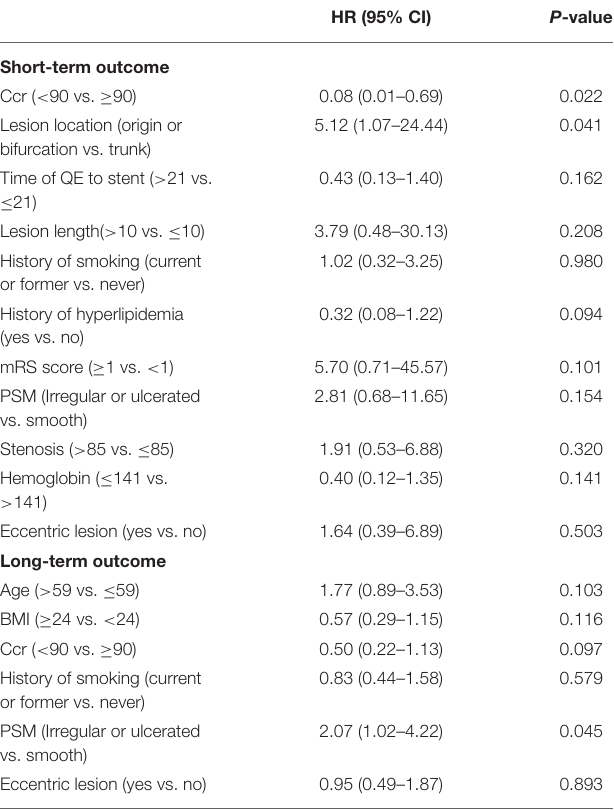
TABLE 2 | Results of Cox multivariable analysis for short or long-term outcome by “change-in-estimate” method. HR (95% CI) P